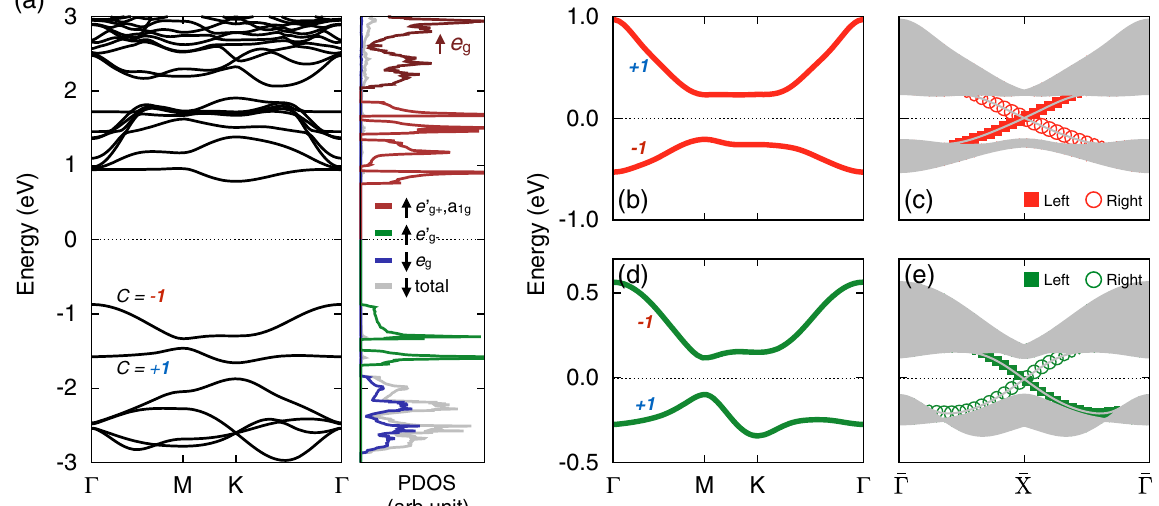
Fig. 3 a Band structure and projected density of states (PDOS) of single-layer BFPO (SL-BFPO), where Fe up spin bands (depicted as brown , dark red , and green lines in PDOS) are mostly shown above − 2eV with respect to the Fermi level. Chern numbers for four bands near the Fermi level are shown. Note that, the single-layer band structure is almost identical to the bulk band structure, except the position of Ba s -bands around 1~2 eV above the Fermi level as shown in Supplementary Material. U eff = 3 eV is employed for Fe 3 d orbital. b Bulk e ′ g ± bands of SL- LFPO. The occupied and unoccupied e ′ g ± bands are characterized by Chern number C = − 1 and +1 per a Fe 2 (PO 4 ) 2 layer, respectively. c Zigzag edge spectrum of LFPO, where the size of fi lled square and empty circular symbols depicting the edge weights. d , e show the bulk and edge bands of SL-CFPO, respectively, with prevailing e ′ g − character. For LFPO and BFPO, U eff = 4 eV is employed (color online)